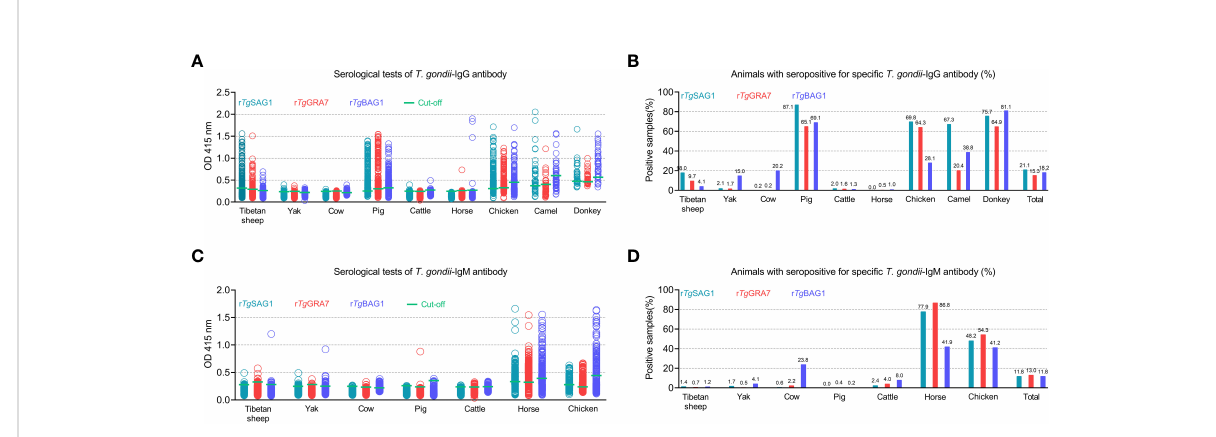
FIGURE 3 Detection of T. gondii IgG (A, B) and IgM (C, D) antibodies in various animals in the Qinghai-Tibet Plateau by the indirect ELISA methods based on SAG1, GRA7 and BAG1 antigens in this